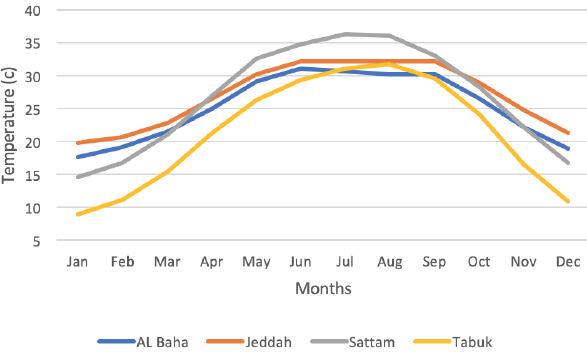
Figure 7: Monthly average temperature at the selected